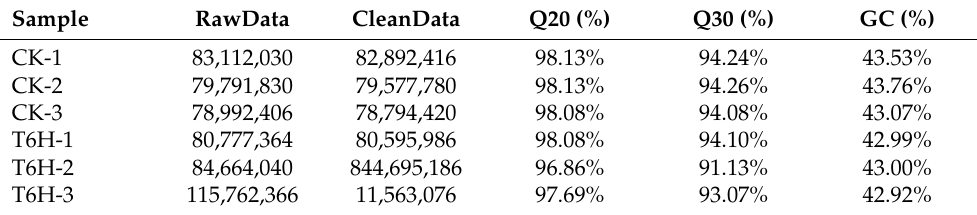
Table 1. Statistical data of RNA-seq reads for the six libraries constructed from leaves treated with H 2 O and SA.